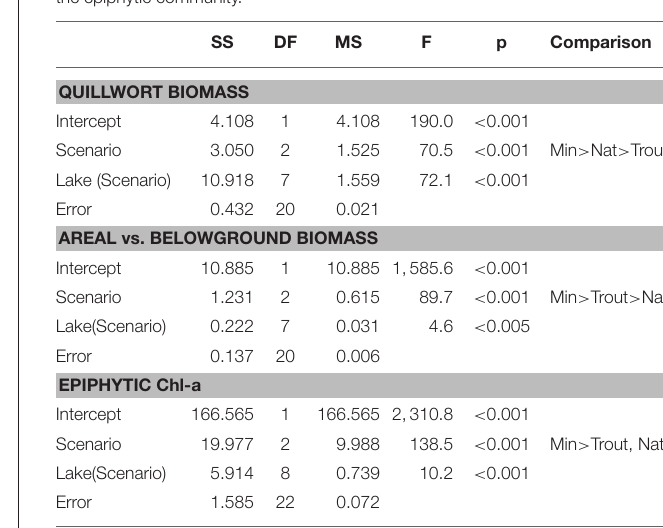
TABLE 4 | Summary of the Nested ANOVAs [var = Scenario + Lake (Scenario) + error] of quillwort meadow biomass, areal vs. belowground biomass and Chl-a of the epiphytic